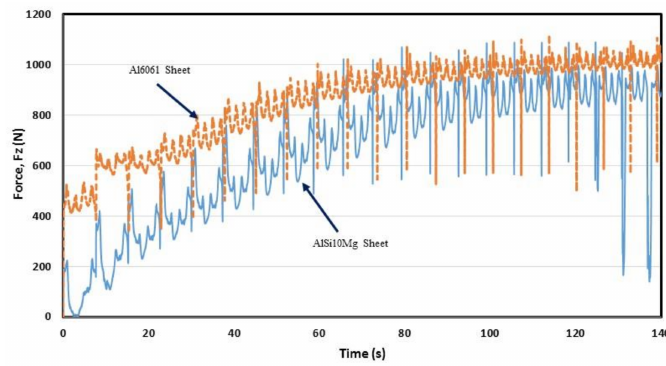
Figure 11. Collected forming forces, F z , on AM AlSi10Mg and Al6061 SPIFed parts. Table 3. Experimental data for Al6061 sample thickness variation as a function of the SPIF depth. Adapted by permission from the International Journal of Advanced Manufacturing Technology